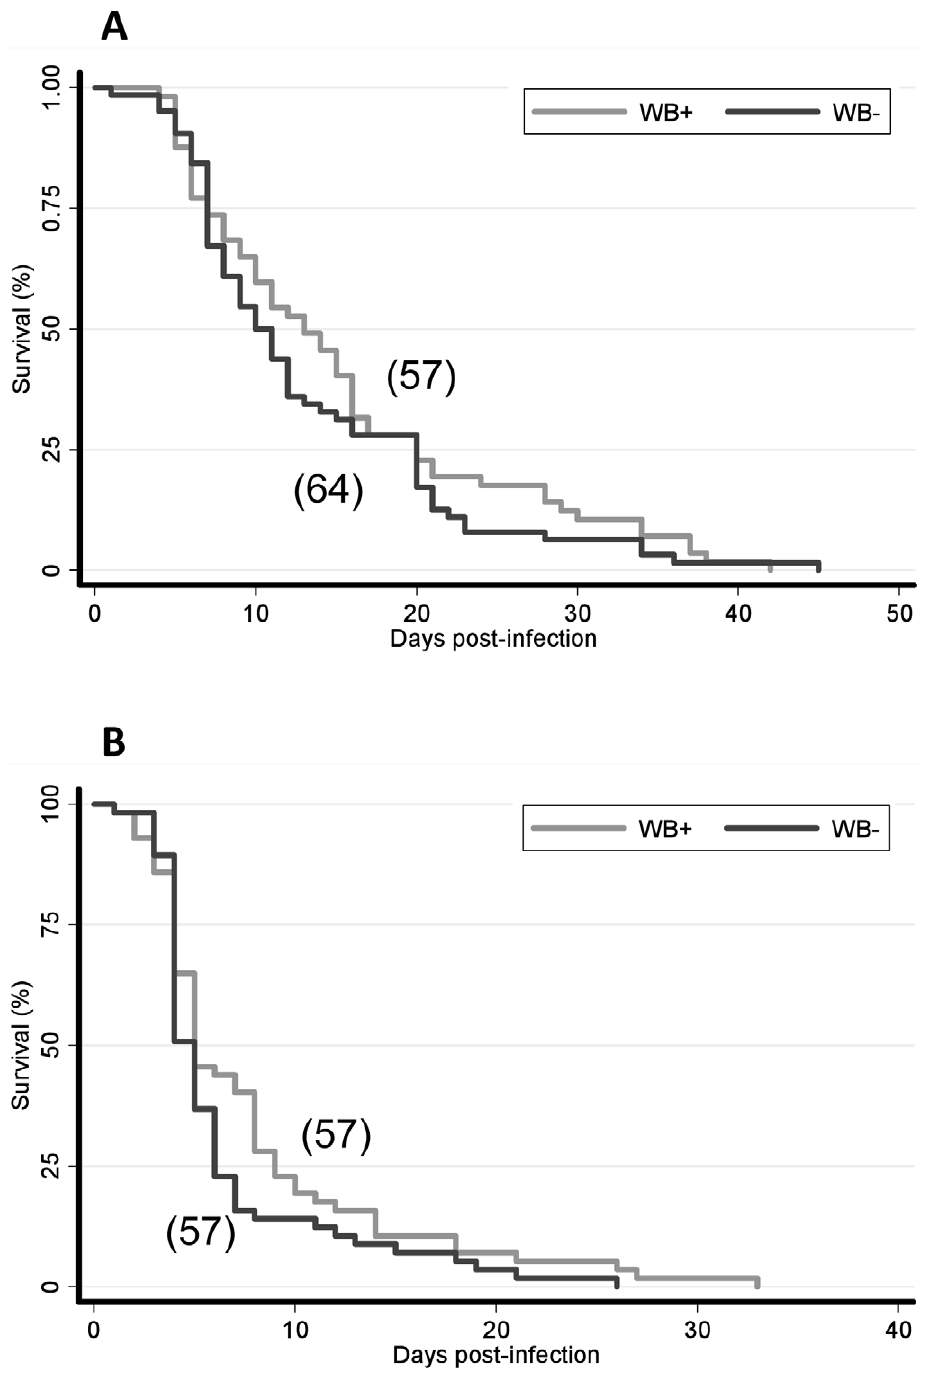
Figure 6. Survival of Wolbachia -infected and Wolbachia -uninfected Ae.albopictus after infection with DENV-2. Mosquitoes were fed on a DENV-2 blood-meal at a titer of 10 7 FFU/mL and maintained at 28 u C. Two replicates (A, B) are shown. The survival curves were not significantly different between Wolbachia -infected and Wolbachia -uninfected mosquitoes fed with DENV-2 (logrank test, p . 0.05). In brackets, the number of females is